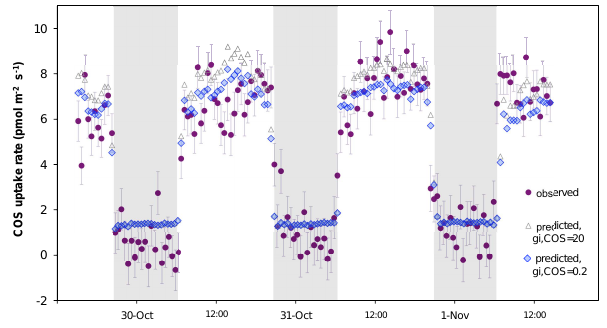
Fig. 1. Leaf COS uptake predicted from transpiration data (Eq. (4), assuming R w − COS =2 and constant internal conductance, g i COS =0.2), and observed uptake rates from measurements on Fa- gus sylvatica in laboratory chambers (original data from Sandoval- Soto et al., 2005). For comparison, we also show predicted rates where internal conductance is assumed to be a negligible limitation to COS diffusion ( g i COS =20). Shaded areas indicate measurements in the dark.